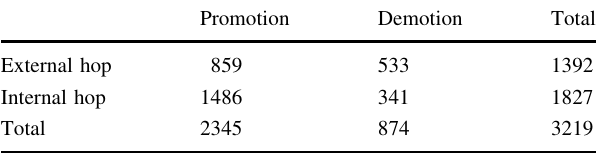
Table 5 Hop classification statistics for Switzerland